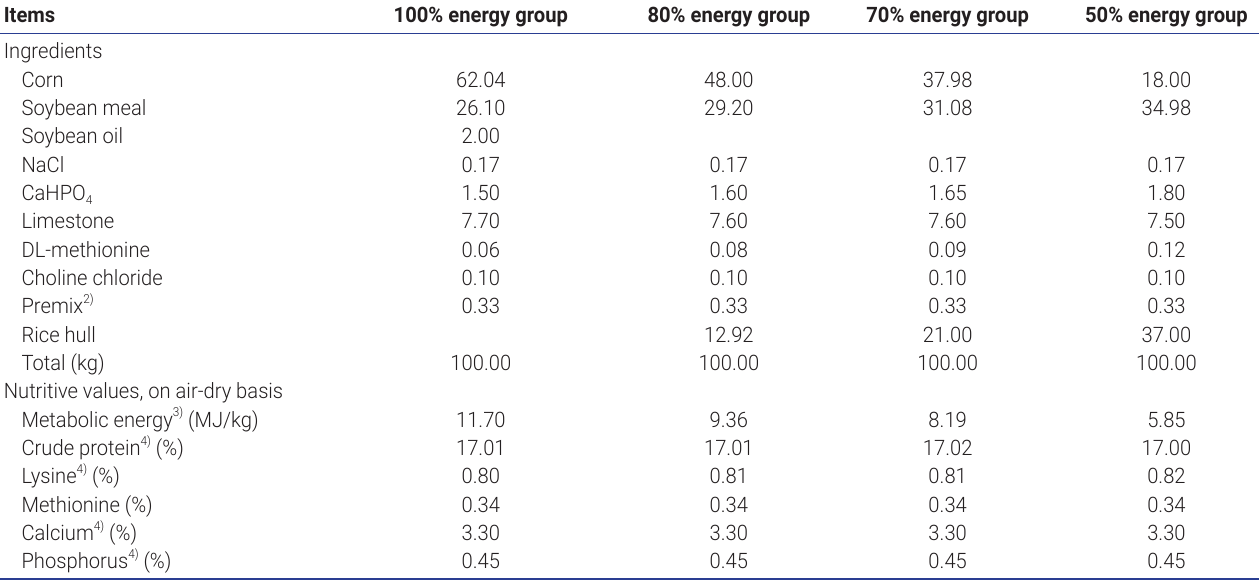
Table 1. Composition (kg/100 kg) of diets 1) for broiler breeders during the laying period